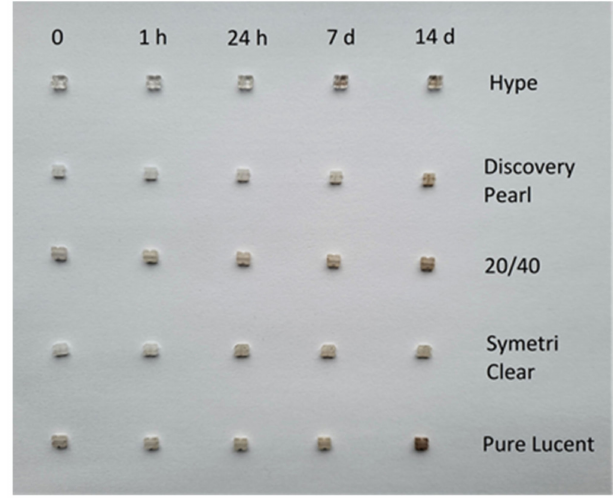
Figure 1. Aesthetic orthodontic brackets treated with coffee.